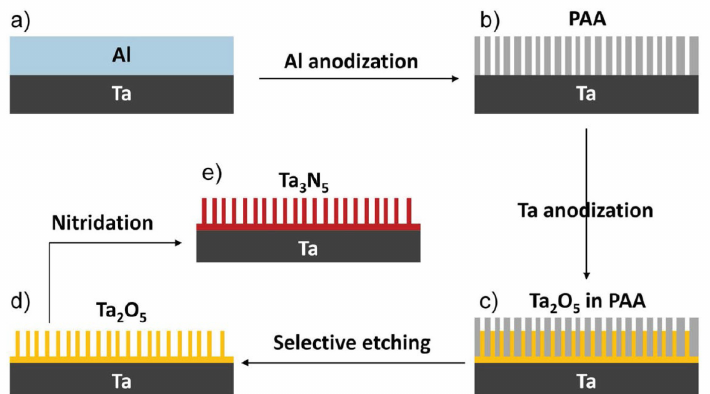
Figure 7. Schematic process for the fabrication of vertically aligned Ta 3 N 5 nanorod array. ( a ) Al layer coated on a clean Ta substrate by thermal evaporation. ( b ) PAA mask formed by anodizing the Al layer in 0.3 M oxalic acid. ( c ) Ta 2 O 5 nanorods embedded in the PAA mask by anodizing the Ta substrate through the PAA mask in 0.5 M boric acid. ( d ) Ta 2 O 5 nanorod array obtained by selectively etching the PAA mask with 5% phosphoric acid. ( e ) Ta 3 N 5 nanorod array obtained by nitridation of the Ta 2 O 5 nanorod array in an NH 3 atmosphere. Reproduced with permission from [110].